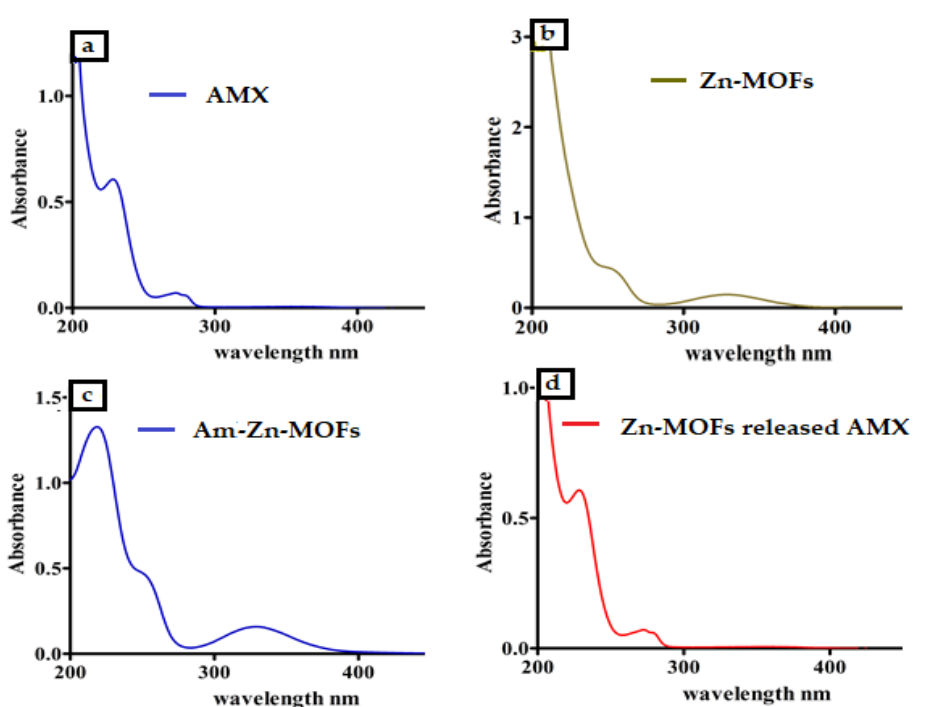
Figure 2. The UV spectrum of pure AMX showing the peak at 230 nm ( a ). UV spectrum of Zn-MOFs showing the peak at 326 nm ( b ). UV spectrum of AMX-loaded Zn-MOFs showed a slight variation in AMX peak ( c ). UV spectrum of AMX after its release from Zn-MOFs ( d ). Table 1. Size, PDI, zeta potential, and encapsulation efficiency of synthesized Zn-MOFs. Samples